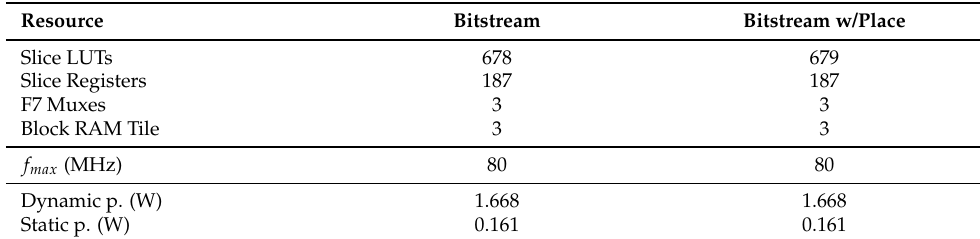
Figure 11. Device image from Vivado of a TMR design after using the placement constraints flow. Table 2. Implementation results of a TMR implementation with and without placement constraints (@60 MHz).